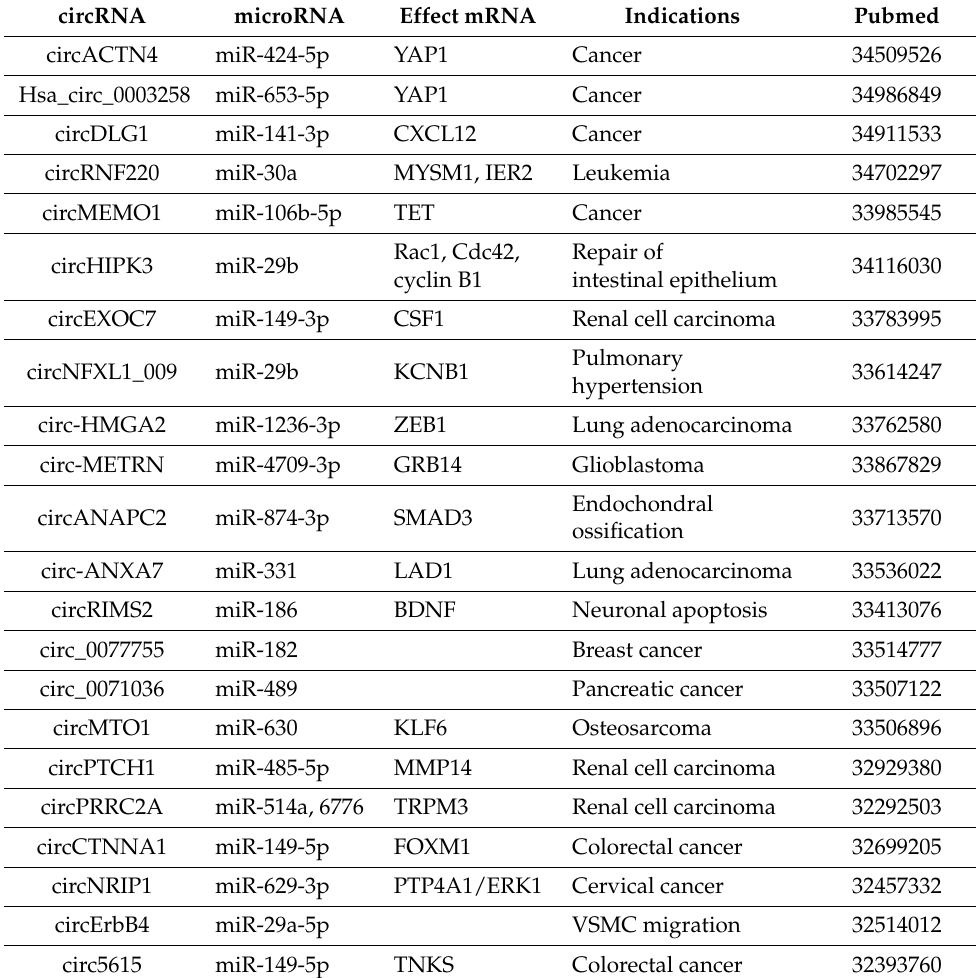
Table 6. Differentially expressed circRNAs from circRNA microarray profiling, analyzed for miRNA sponge functions (published in years